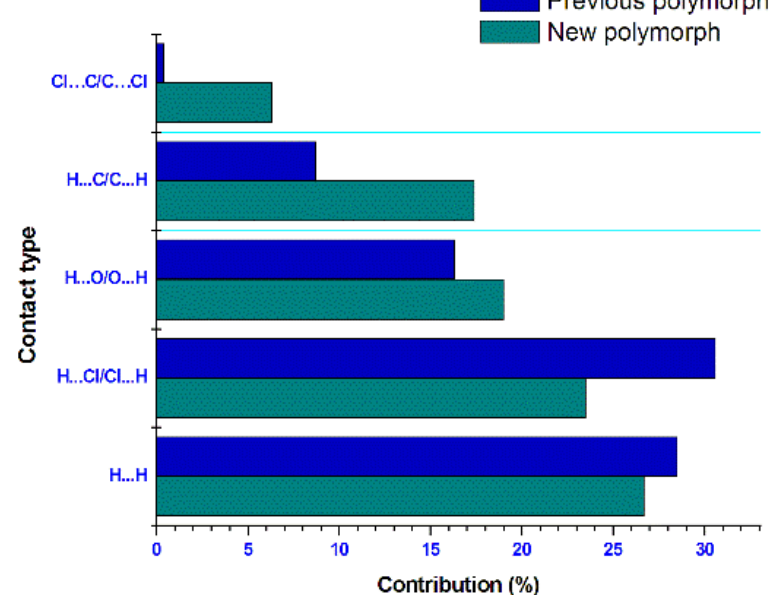
Figure 7. Relative contribution (%) of various intermolecular interactions to the Hirshfeld surface area of the two polymorphs.